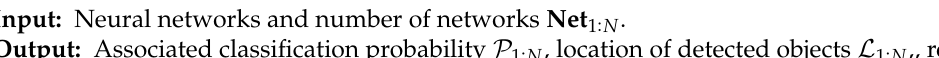
Algorithm 1 Deep